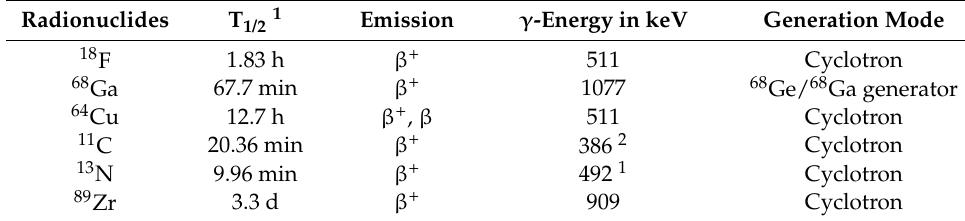
Table 2. List of radionuclides used for PET imaging [26–28]. Radionuclides T 1/2 1 Emission γ -Energy in keV Generation Mode 18 F 1.83 h β + 511 Cyclotron 68 Ga 67.7 min β + 1077 511 Cyclotron 11